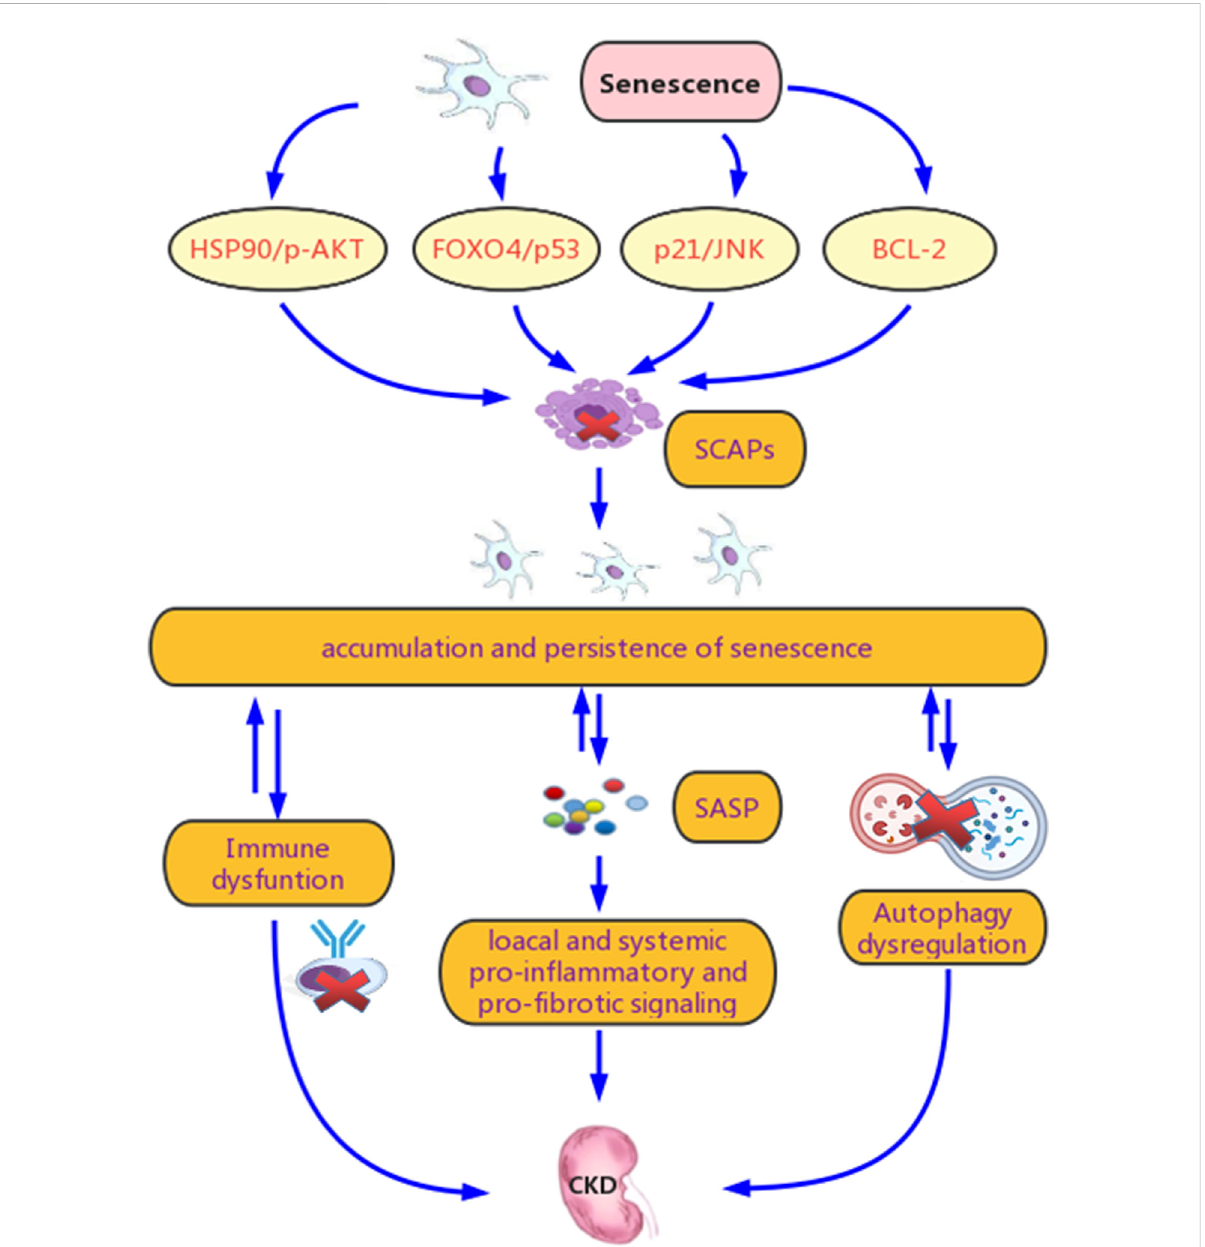
FIGURE 2 Potential mechanisms for senescence promoting chronic kidney disease (CKD). Renal senscence and CKD are tightly connected. Chronic stimulation of various stressors in CKD leads to the continuous and excessive induction of chronic senescent cells and relaease of senescence associated secretory phenotype (SASP), which contributes to their accumulation and persistence. Another crucial reason for their persistence is senescentcellanti-apoptoticpathways(SCAPs),whichpreventssenescentcellsfromclearancemainlythoughtheB-celllymphoma-2(BCL-2), Forkhead box O4 (FOXO4)/p53, p21/JNK and HSP90/p-AKT pathways. Meanwhile, this persistence promotes SASP secretion and spread, induces abnormalrenalrepair,andexacerbaterenal fi brosis,culminatinginCKDprogressionanditssystemiccomplications.Dysregulationofautophagyand immune system are involved in both the persistence of senescence and the progression of